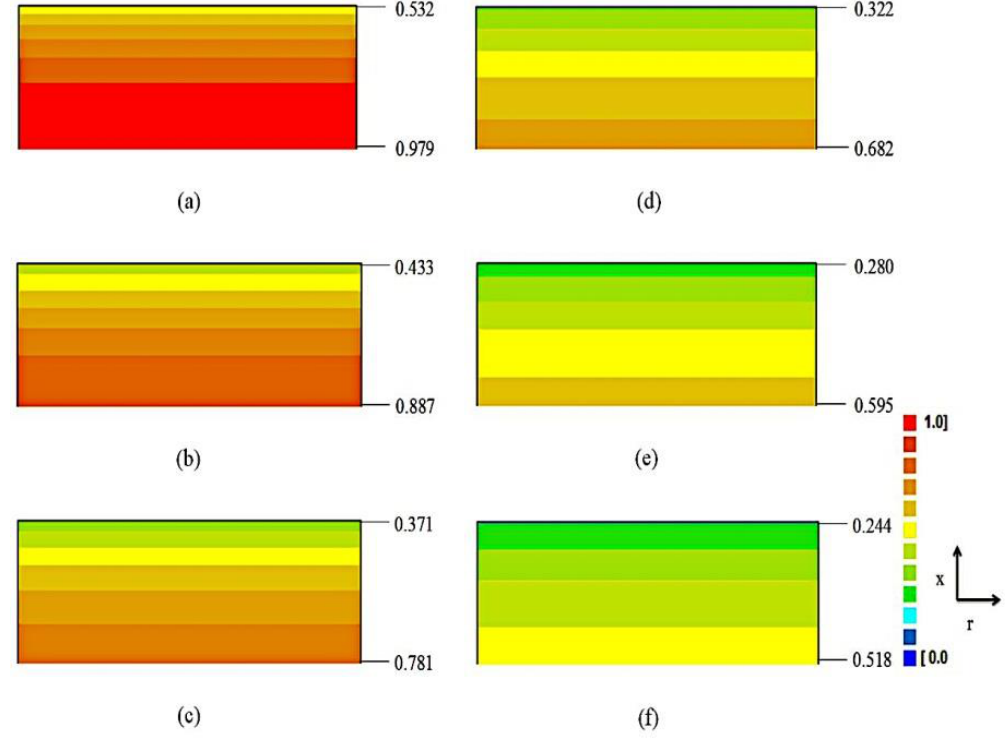
Figure 5. Distributions of dimensionless moisture contents ( MR ) for drying at 50 °C a: ( a ) t = 60 min; ( b ) 120 min; ( c ) 180 min; ( d ) 240 min; ( e ) 300 min and ( f ) 360 min. Rectangles are not at scale. (For interpretation of the references to color in this figure legend, the reader is referred to the web version of this article.).